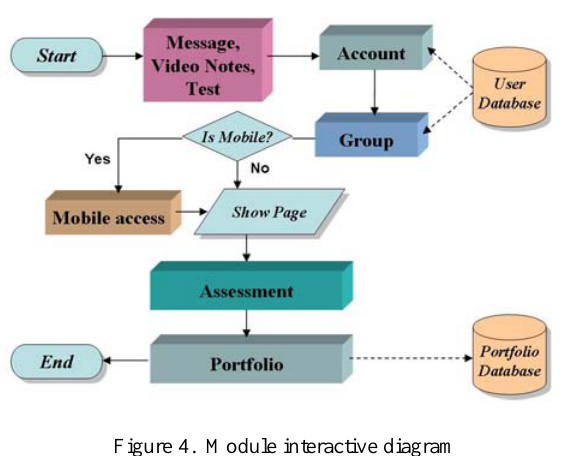
Figure 4. Module interactive